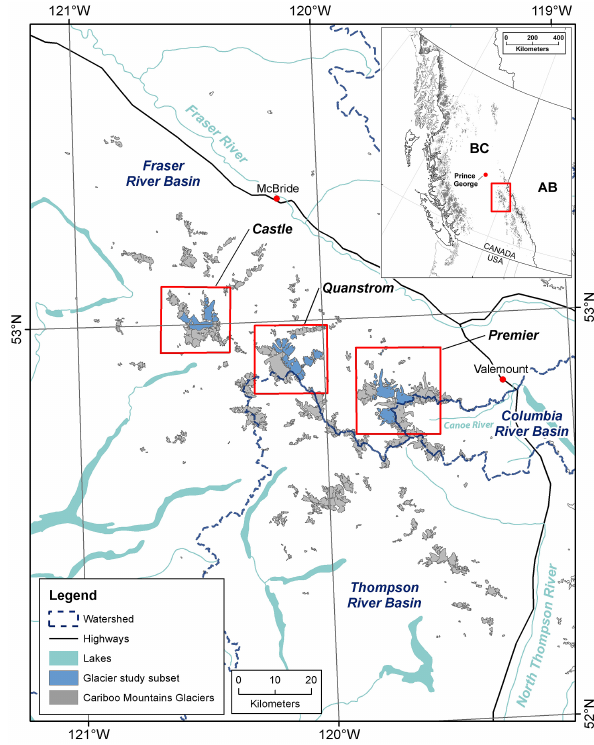
Figure 1. Study area: the three red rectangles indicate subregions in this study (Castle, Quanstrom, and Premier) and the location of the three maps in Fig.